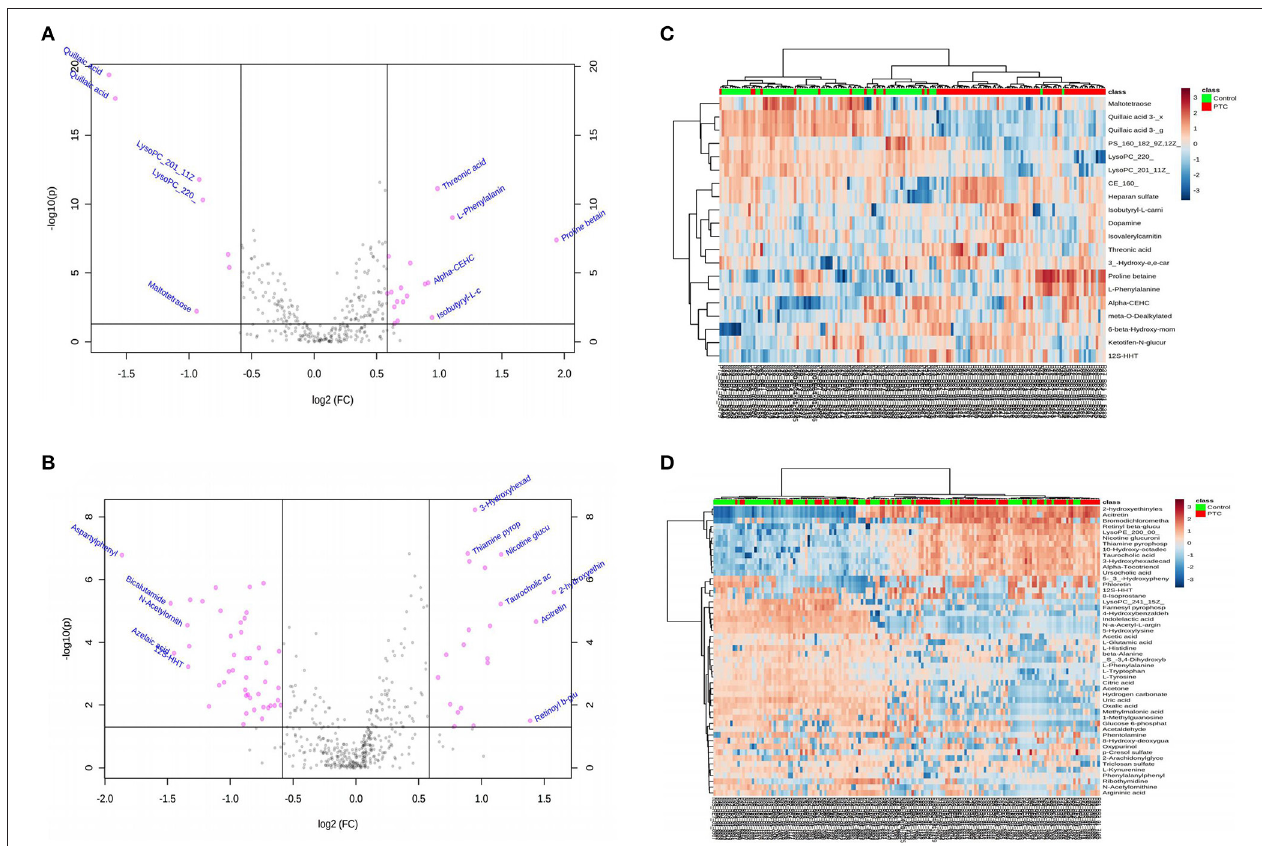
FIGURE 1 | (A,B) Volcano diagrams showing the changes in PTC and the most important metabolites of healthy subjects. (A) Represents the volcano map in positive ion mode, and (B) represents the volcano map in negative ion mode. The red dots in the figure represent differential metabolites, and the black dots represent no significant difference. The red dot on the right side of the figure represents the upregulated metabolite, and the red dot on the left side represents the downregulated metabolite. x-axis corresponds to log 2 (fold change) and y-axis corresponds to –log 10 ( p- value). (C,D) Heatmap visualization of metabolomics data with hierarchical clustering analysis (HCA). (C) Represents the heatmap in positive ion mode, and (D) represents the heatmap in negative ion mode. The red color represents the peak value that is relatively large; the blue color represents the peak value that is relatively small; and the gray color represents the metabolite peak value of zero. The more similar the color, the more similar the peak value. The panel on the right represents the different metabolites. The upper dendritic structure is clustered according to the degree of metabolite similarity across samples. The red line below the dendritic structure represents the PTC group, and the green line represents the control group. PTC, papillary thyroid carcinoma; Control, healthy